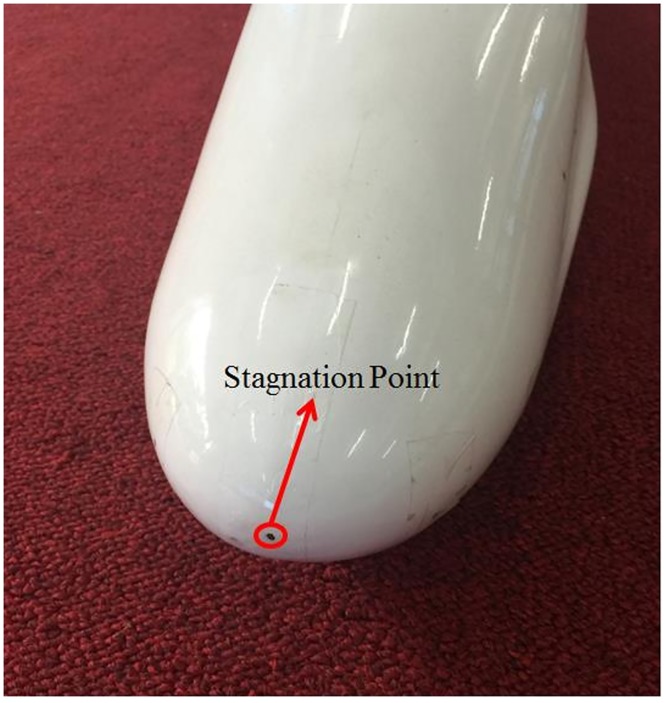
Stagnation point.